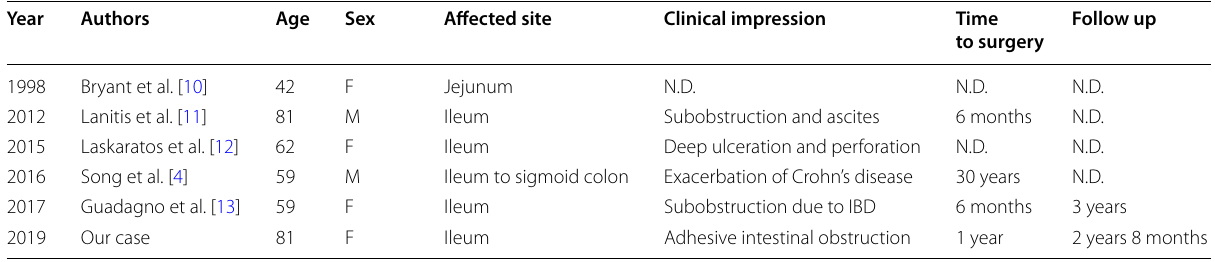
N. D. not documented, IBD Inflammatory bowel